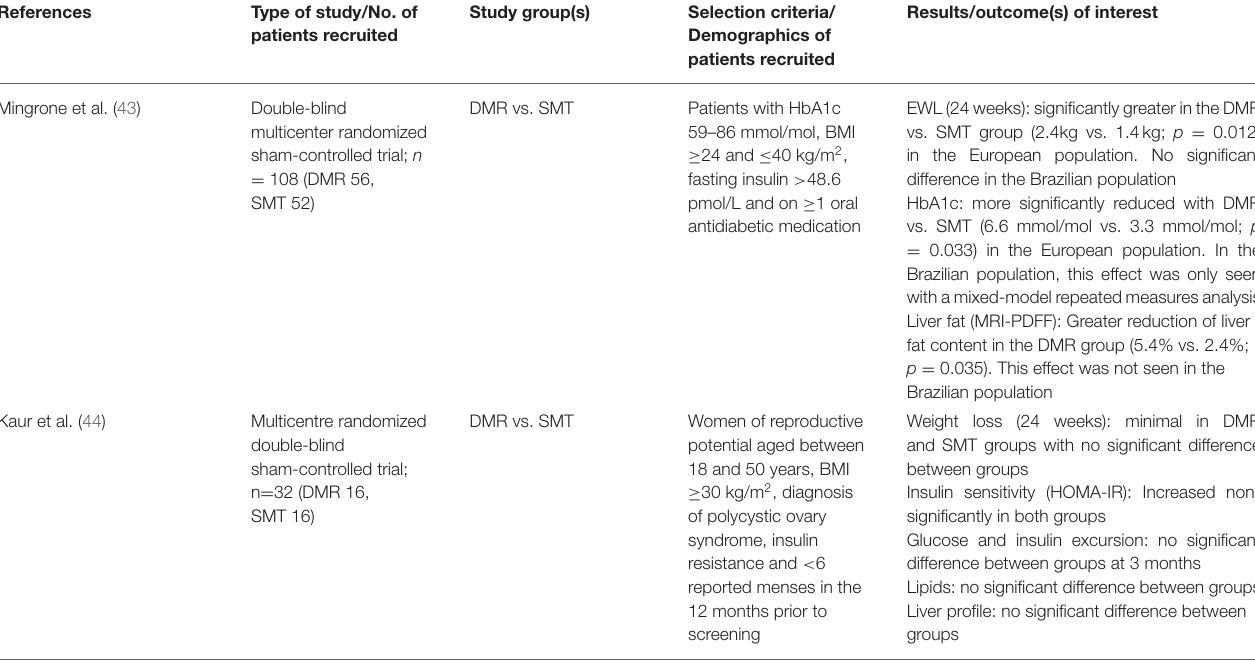
TABLE 6 | Studies included for the study of DMR on Metabolic Syndrome and related comorbidities in adults. Type of study/No. of Study group(s) Selection criteria/ Results/outcome(s) of patients recruited Demographics of patients recruited